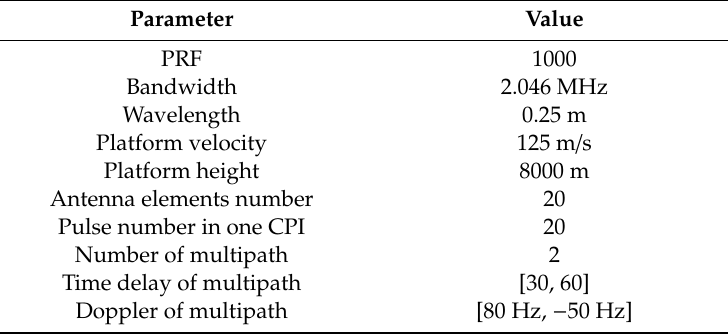
Table 1. Simulation parameters.